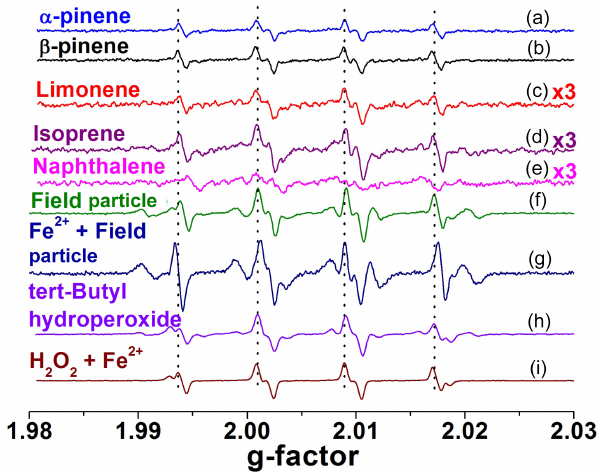
Figure 2. EPR spectra of sample solutions mixed with the spin- trapping agent BMPO: (a) α -pinene SOA, (b) β -pinene SOA, (c) limonene SOA, (d) isoprene SOA, (e) naphthalene SOA, (f) 180–320nm size field particles, (g) 180–320nm size field par- ticles mixed with Fe 2 + , (h) tert -butyl hydroperoxide solution and (i) H 2 O 2 solution with Fe 2 + . The four peaks (dotted lines) are char- acteristic of BMPO-OH